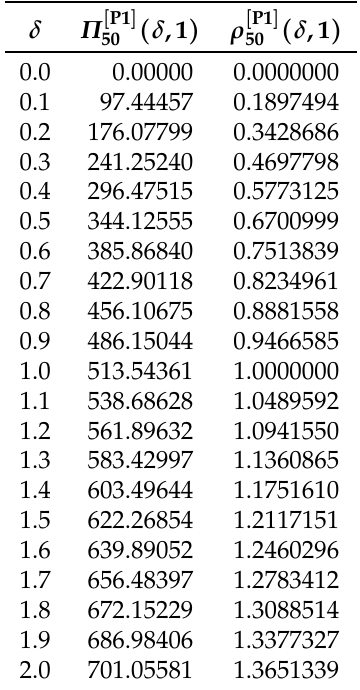
Table 9. Product P1 (stand-alone); x = 50, b =